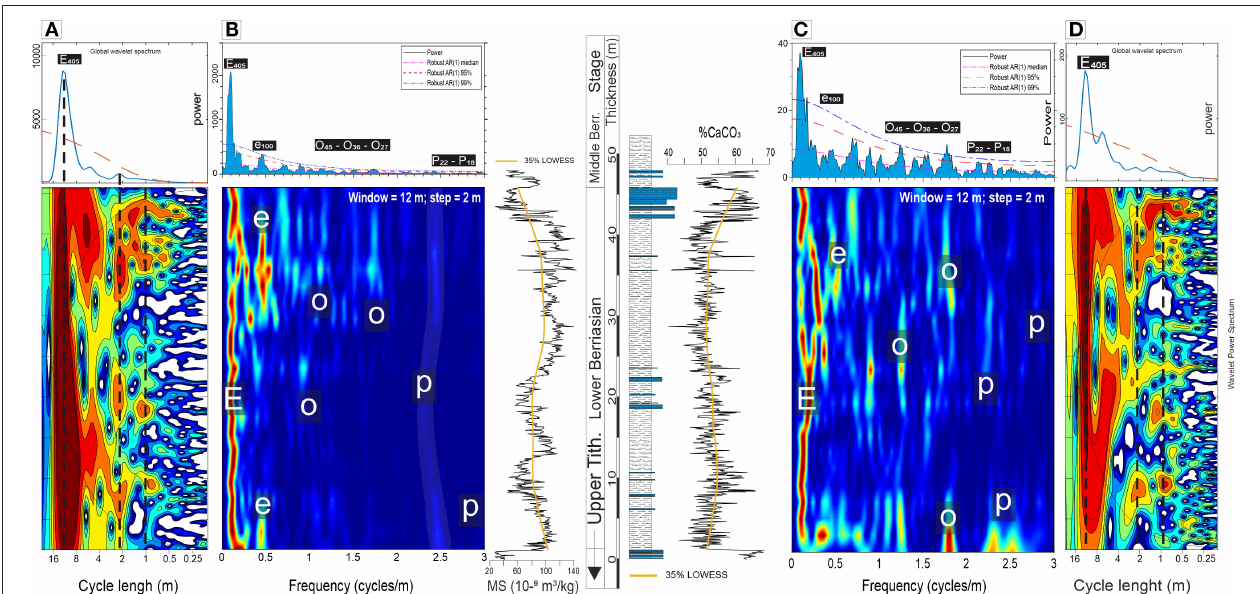
FIGURE 6 | Spectral analysis of the Lower Sidi Khalif Formation. (A,B) are, respectively, the continuous wavelet transform (CWT) and the evolutionary spectrogram (evoFFT coupled to 2 π -MTM analysis) of the MS signal. (C,D) are, respectively, and the evolutionary spectrogram (evoFFT coupled to 2 π -MTM analysis) and the continuous wavelet transform (CWT) of the % CaCO 3 signal.